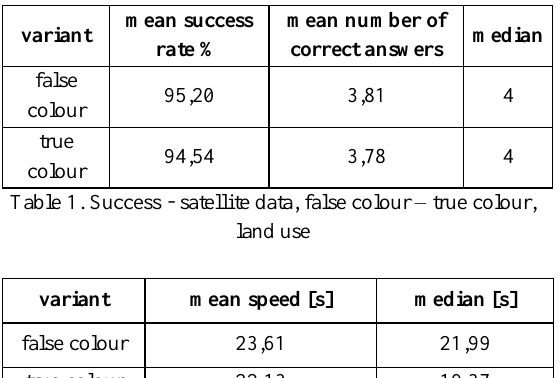
Table 1 and Table 2.